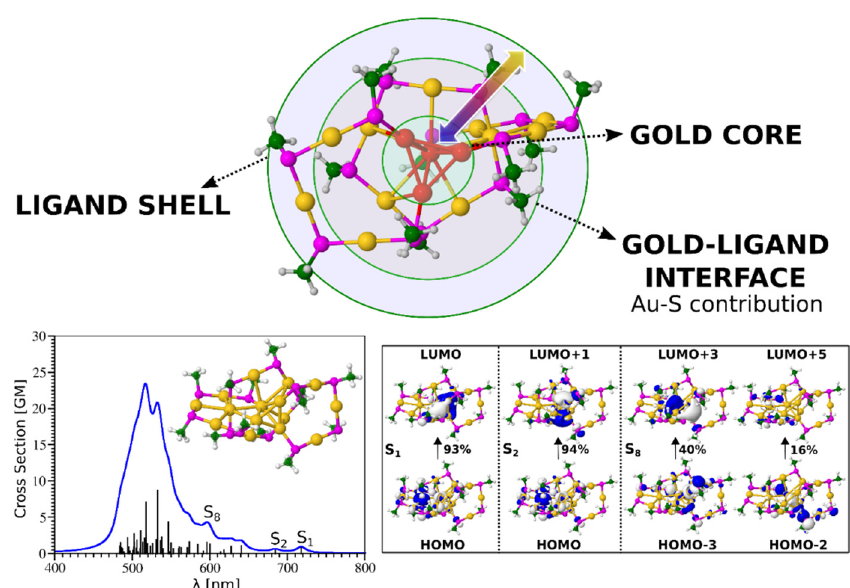
Figure 3. Diagram showing the view of liganded gold nanoclusters as multi-shell system on an example of Au 15 (SCH 3 ) 13 (upper panel). TDDFT two-photon absorption spectrum (bottom left) and molecular orbitals (bottom right) involved in transitions for an Au 15 (SCH 3 ) 13 nanocluster. The upper scheme was adapted from [45] (p. 18). For theoretical methods used for the bottom panel, see [113].